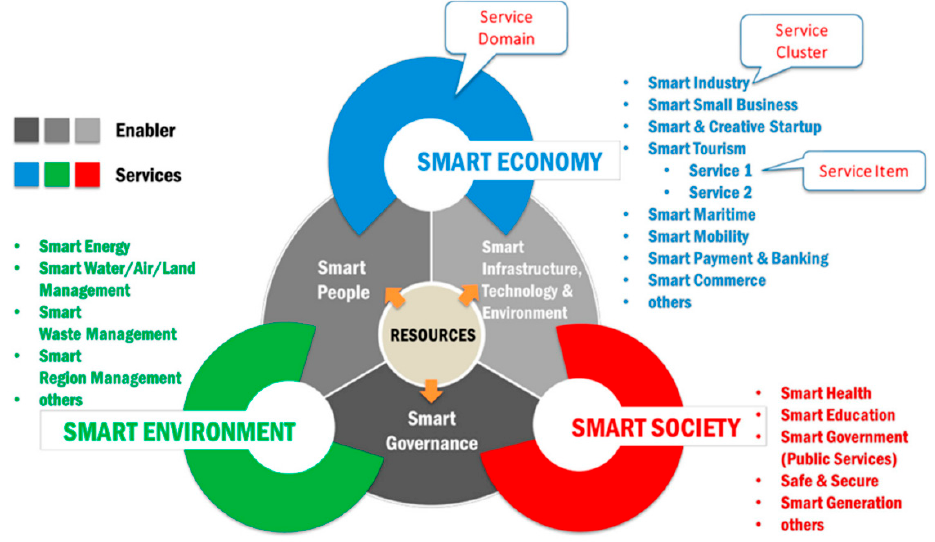
Figure 1. SC model. Source: Kézai et al., 2020. “Smart economy and startup enterprises in the visegrád countries—a comparative analysis based on the Crunchbase database” Smart Cities 3, no. 4: 1477–1494 [20].